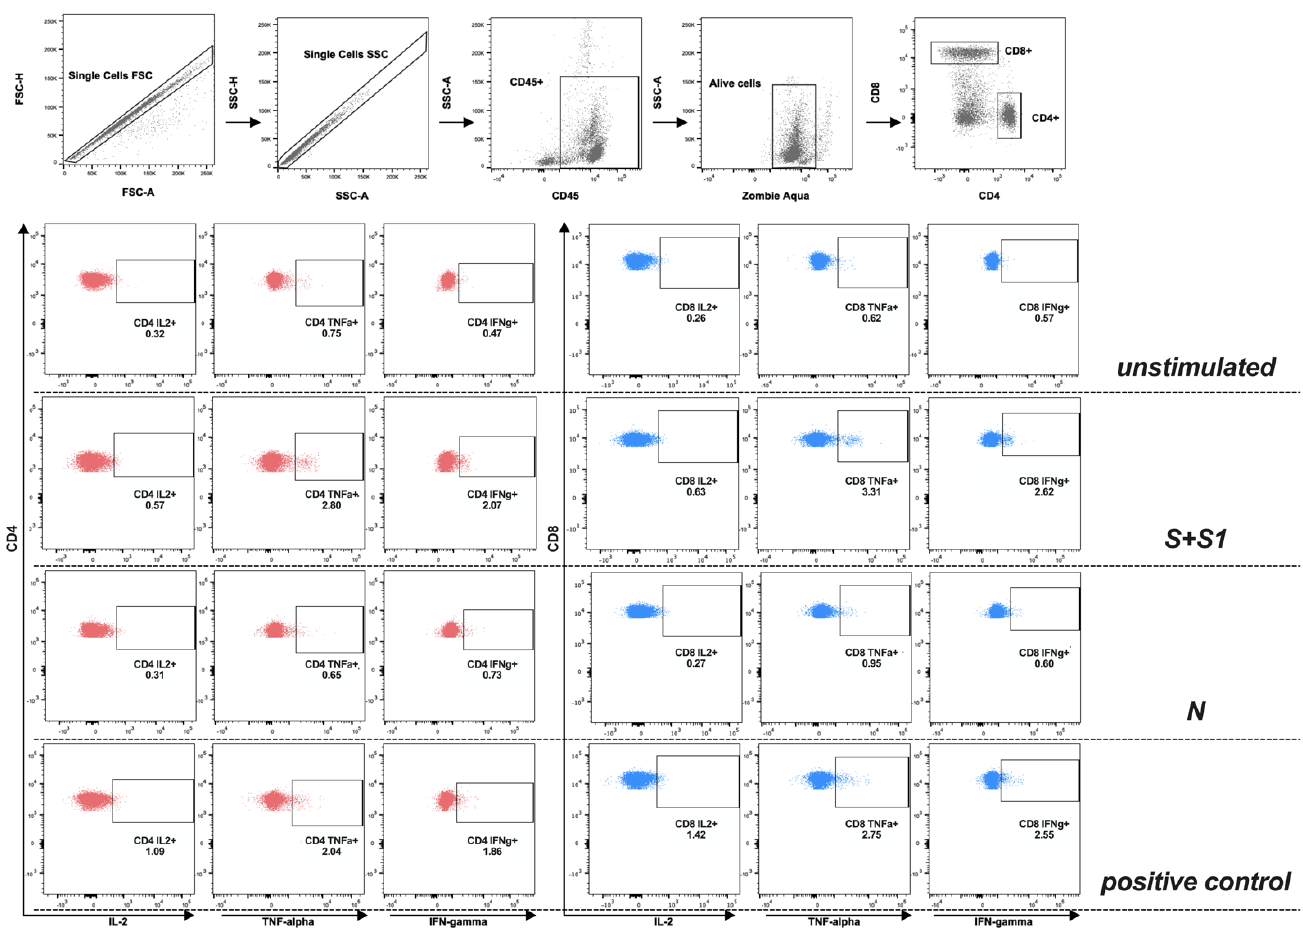
Figure 1. Representative flow cytometry gating strategy showing cytokine-producing cells among CD4+ or CD8+ T-cells. After single cells in forward scatter area (FSC-A) versus height (H) and side scatter area (SSC-A) versus H were plotted, CD45+ cells were identified. Then, dead cells were excluded. Finally, CD4+ and CD8+ T-cells were identified, as well as IL2, IFNγ, and TNFα . S+S1: spike glycoprotein; N: nucleocapsid phosphoprotein.